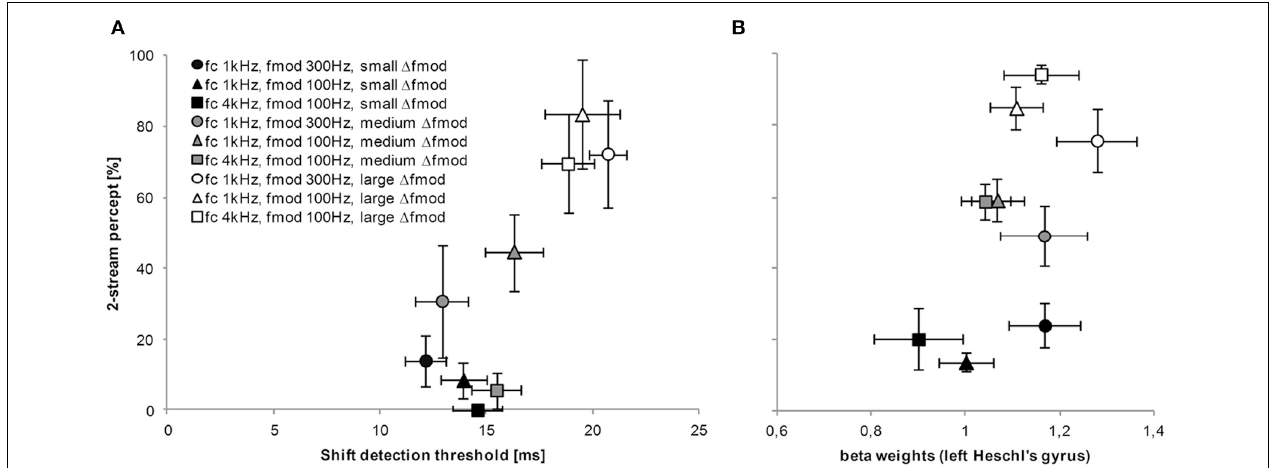
the strength of BOLD responses (beta weights) in left Heschl’s gyrus (x-axis). The symbols represent the three possible combinations of f c , f mod A , and (cid:2) f mod (see legend for values). Generally, the shading of the symbol represent the (cid:2) f mod stimulus condition; The darkest shading represent values for the small (cid:2) f mod stimulus condition, whereas the lightest shading represent values for the large (cid:2) f mod stimulus condition. Mean and error bars (SEM) are